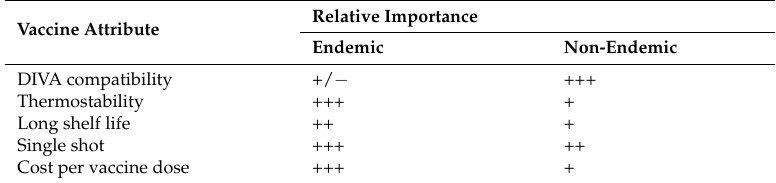
Table 2. Relative importance of vaccine attributes in endemic and non-endemic